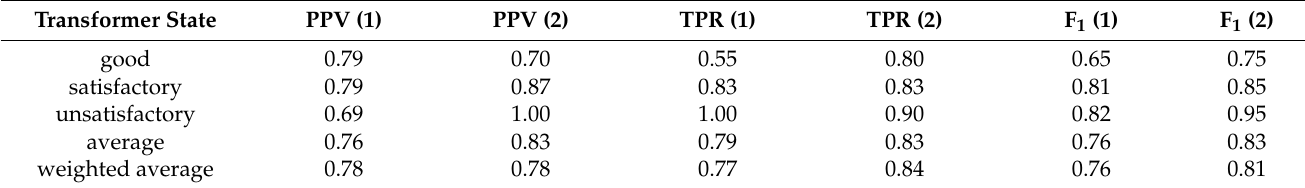
Table 6. Comparison of the single-step classifier (1) and the two-step classifier